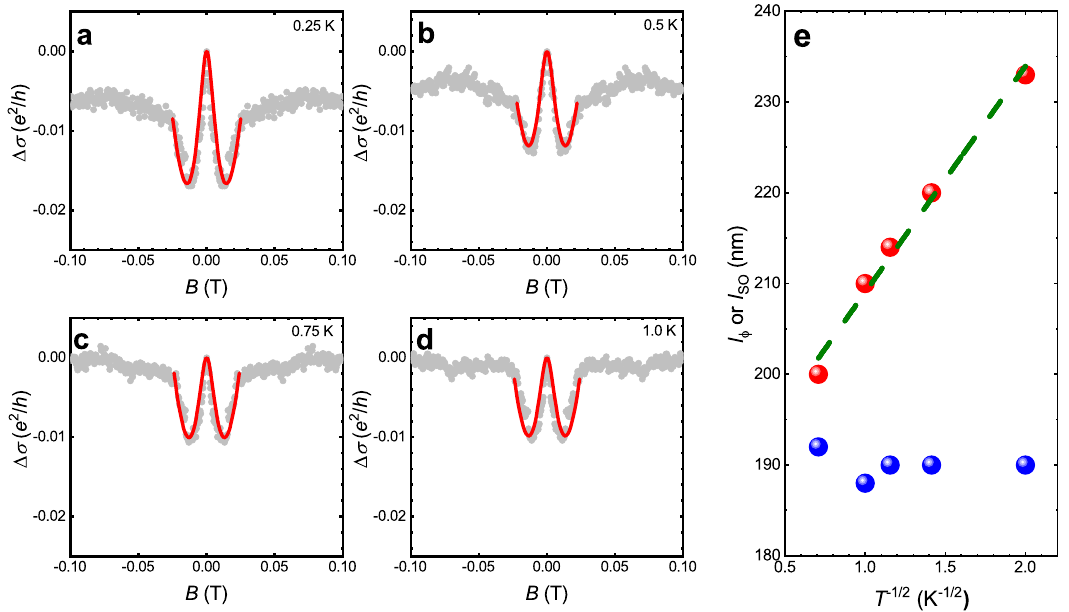
Fig. 3 Fitting of the magnetoconductance (MC) of LTO/KTO. a – d MC at various temperatures. Gray dots are experimental data and red solid lines are fi tting curves based on ILP theory. e The extracted l ϕ (red symbols) and l SO (blue symbols) plotted against T (cid:2) 1 2 . The green dashed line is a linear fi